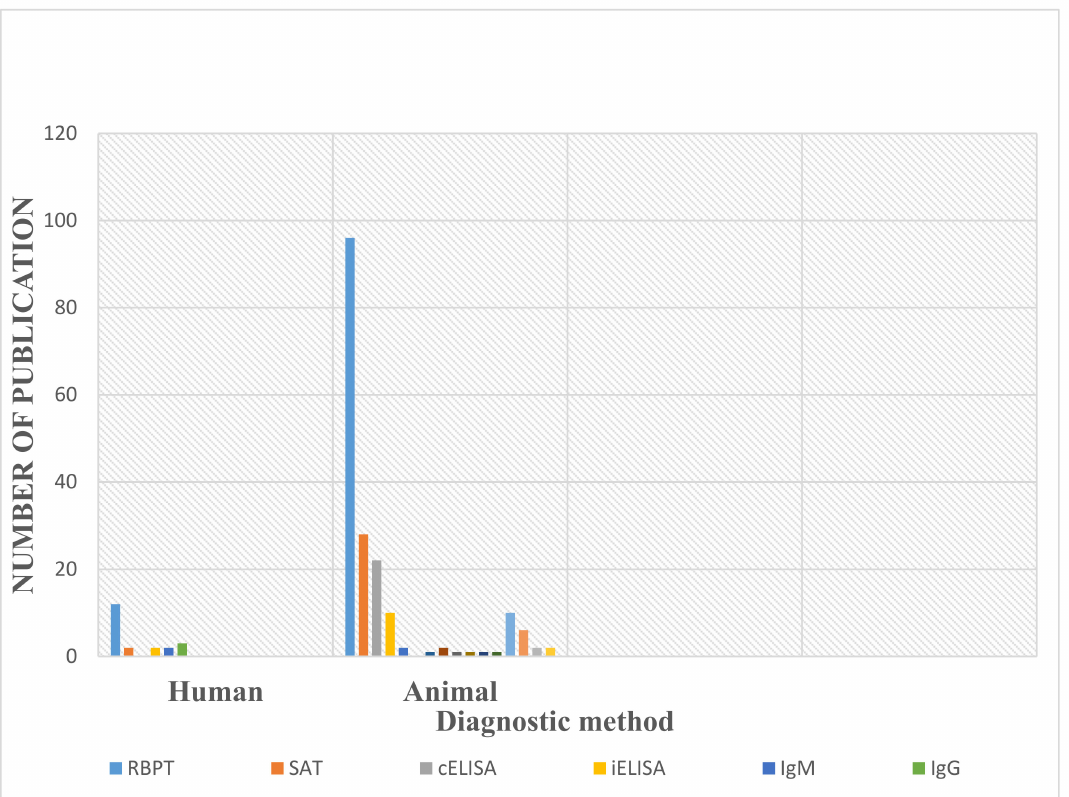
Figure 2. Diagnostic methods used in the detection of human and animal brucellosis in